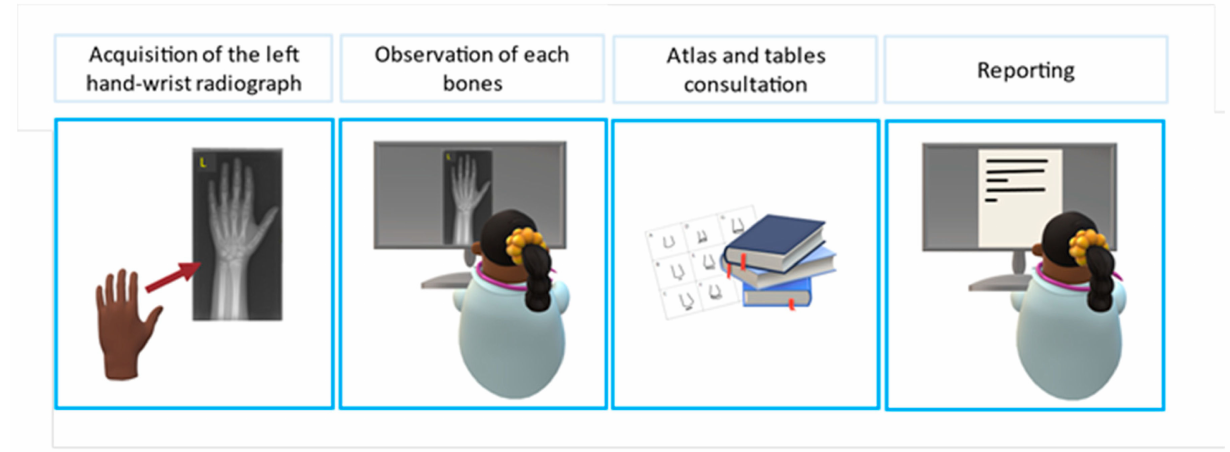
Figure 2. The steps of a traditional time-consuming age assessment